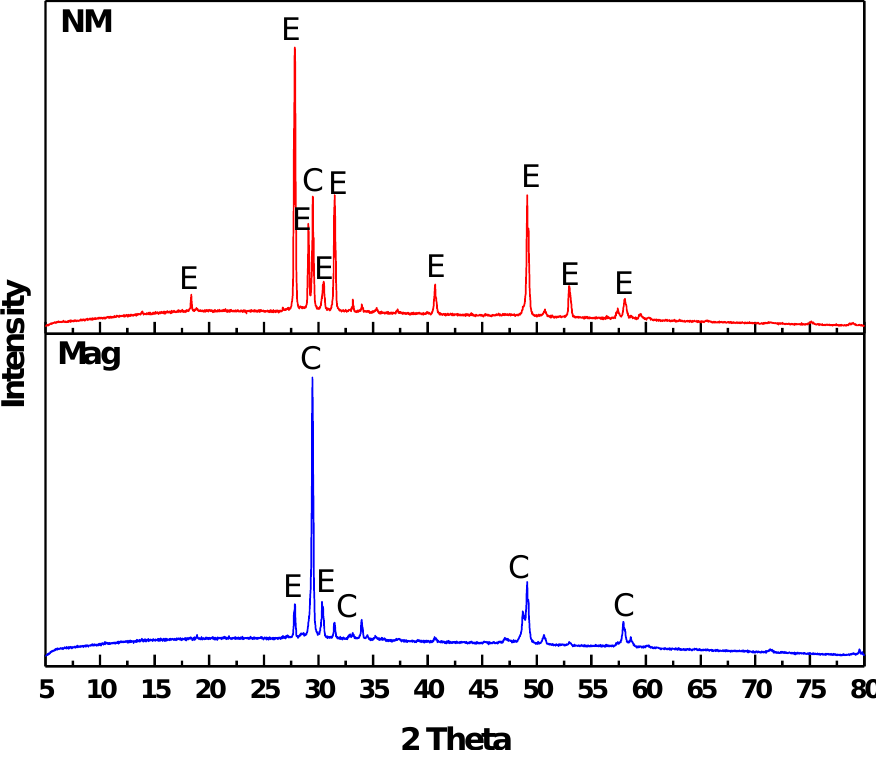
Figure 5. XRD patterns for magnetic and nonmagnetic fraction, C for chalcopyrite, and E for enargite.